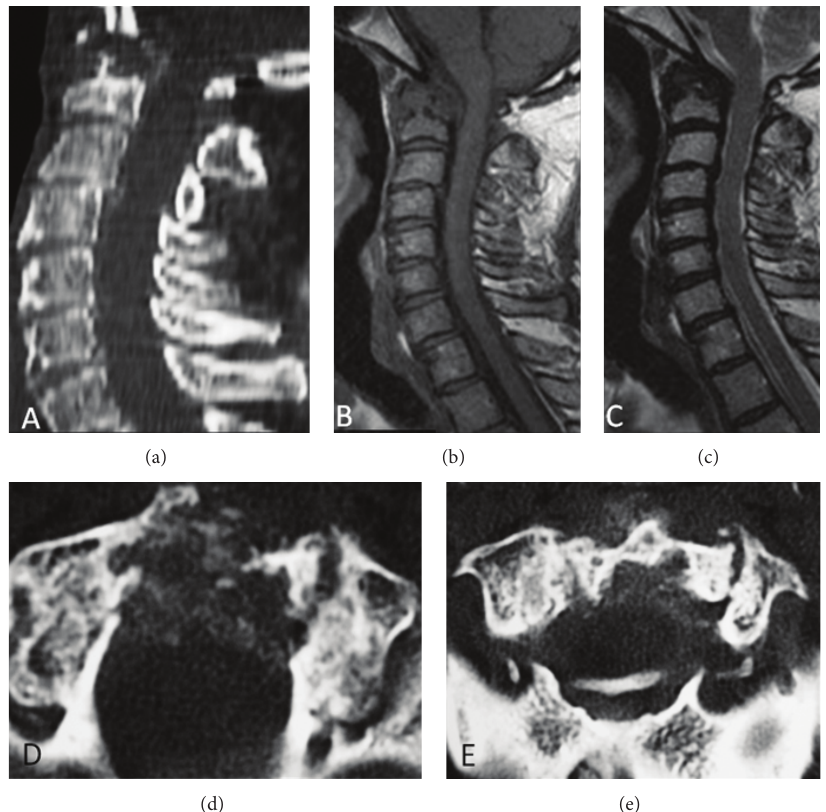
Figure 1: (a) Sagital computed tomography (CT) image shows a destructive lesion of odontoid process. (b) Sagital T1-weighted spin eco and (c) sagital T2-weighted spin eco demonstrating a hypointense mass with compression of the spinal cord. (d) and (e) Axial CT images of this region with well-defined calcification foci within the mass suggesting microcrystal